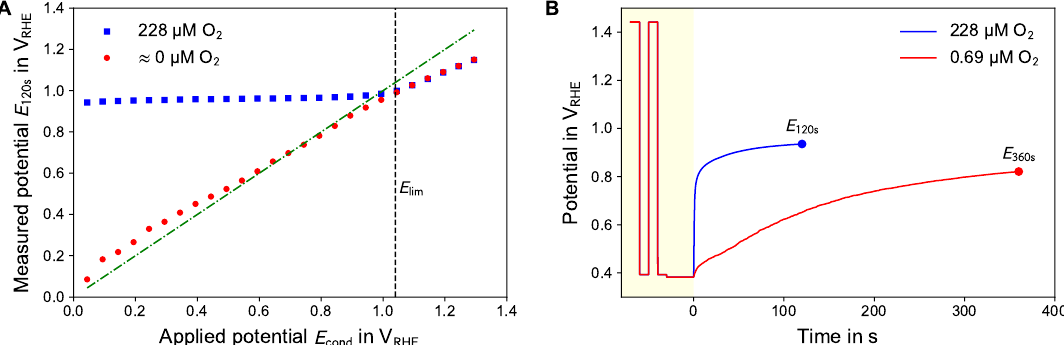
Figure 3. ( A ) The measured potential E 120s as function of the the conditioning potential E cond at the end of the prepolarization phase. Lower E cond increase the difference between measurement in air-saturated and nitrogen-flushed electrolyte. For E cond > E lim the measured potential did not show any oxygen dependency. ( B ) Transient behavior of the measured potential. For lower oxygen concentration (red curve) a prolonged OCP measurement phase is